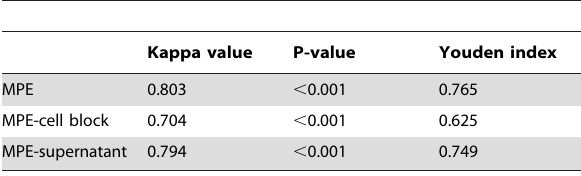
Table 5. Comparison of EGFR mutation between MPEs and matched MPTTs.